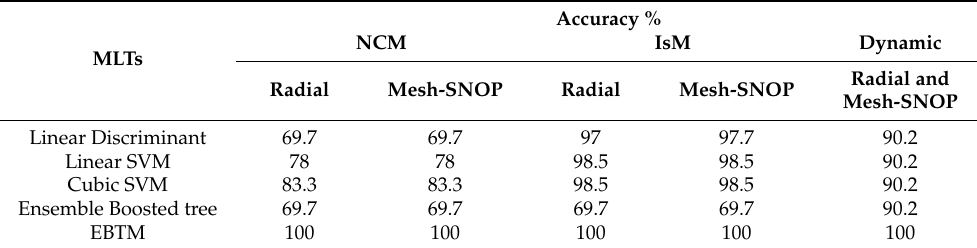
Table 3. Accuracies acquired by several